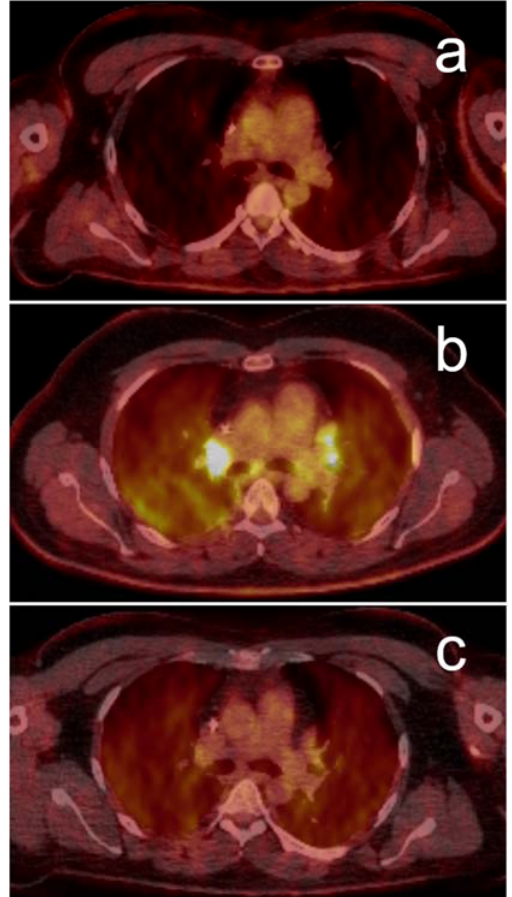
Figure 4. Suspected immune ‐ related sarcoid ‐ like reaction visualized by PET/CT: 37 ‐ year ‐ old man with recurrent metastatic melanoma, a single lung metastasis was surgically removed for diagnostic reasons before treatment with pembrolizumab was initiated. Pre ‐ therapy PET/CT ( a ) shows no evidence of intrathoracic activity. Clinically and in conventional imaging, a complete remission was reached within few months, but a subsequent follow ‐ up PET/CT six months after therapy initiation ( b ) showed bilateral mediastinal and hilar lymphadenopathy and diffuse lung parenchymal uptake. As the patient did not report any respiratory or tumor ‐ specific symptoms, a sarcoid ‐ like reaction was suspected based on PET/CT morphology. Pembrolizumab was resumed, but a timely PET/CT surveillance scan after three months was scheduled, which showed spontaneous resolution of the hypermetabolic lesions ( c ).